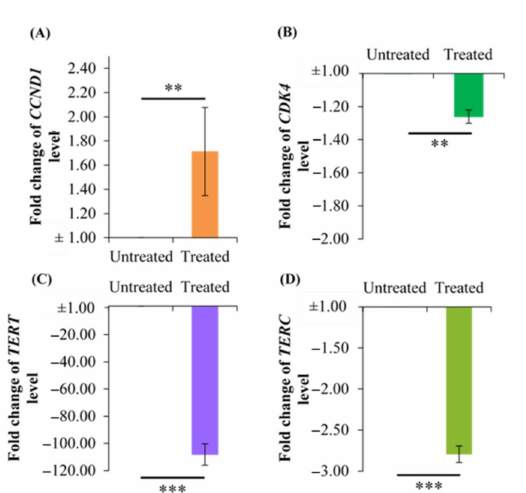
Figure 6. Effect of 10.54 µ g/mL berberine-treated HCT 116 at 48 h on ( A ) CCND1 , ( B ) CDK4 , ( C ) TERT , and ( D ) TERC levels. Changes in RNA levels are expressed as fold change in RNA levels relative to untreated HCT 116 at 48 h. Values are mean ± standard error of quadruplicate. Mean with ** (double asterisks) or *** (triple asterisks) differ significantly at p < 0.01 or p < 0.001, respectively.